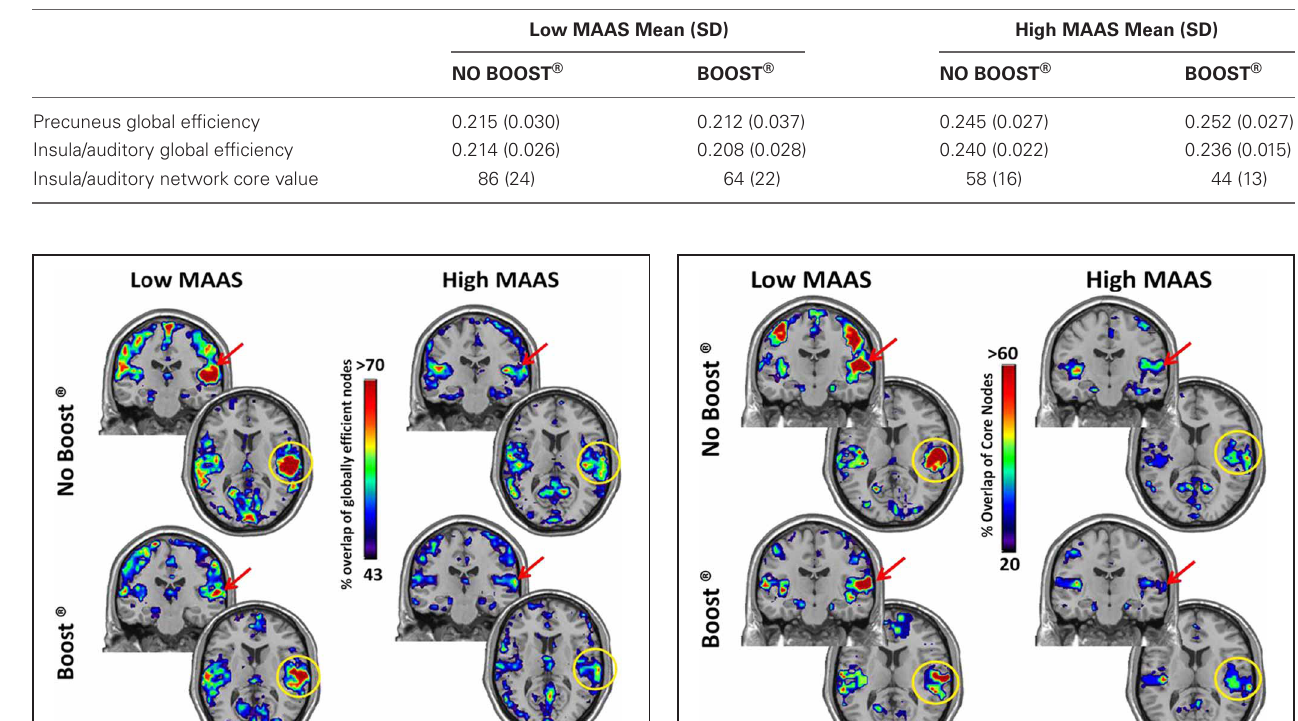
Table 2 | Quantitative network metrics from region-of-interest analyses.